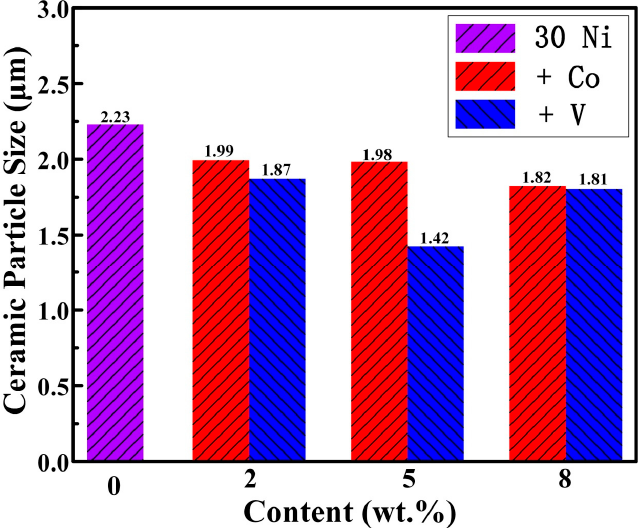
Figure 6. Average size of ceramic particles with different Co and V contents.